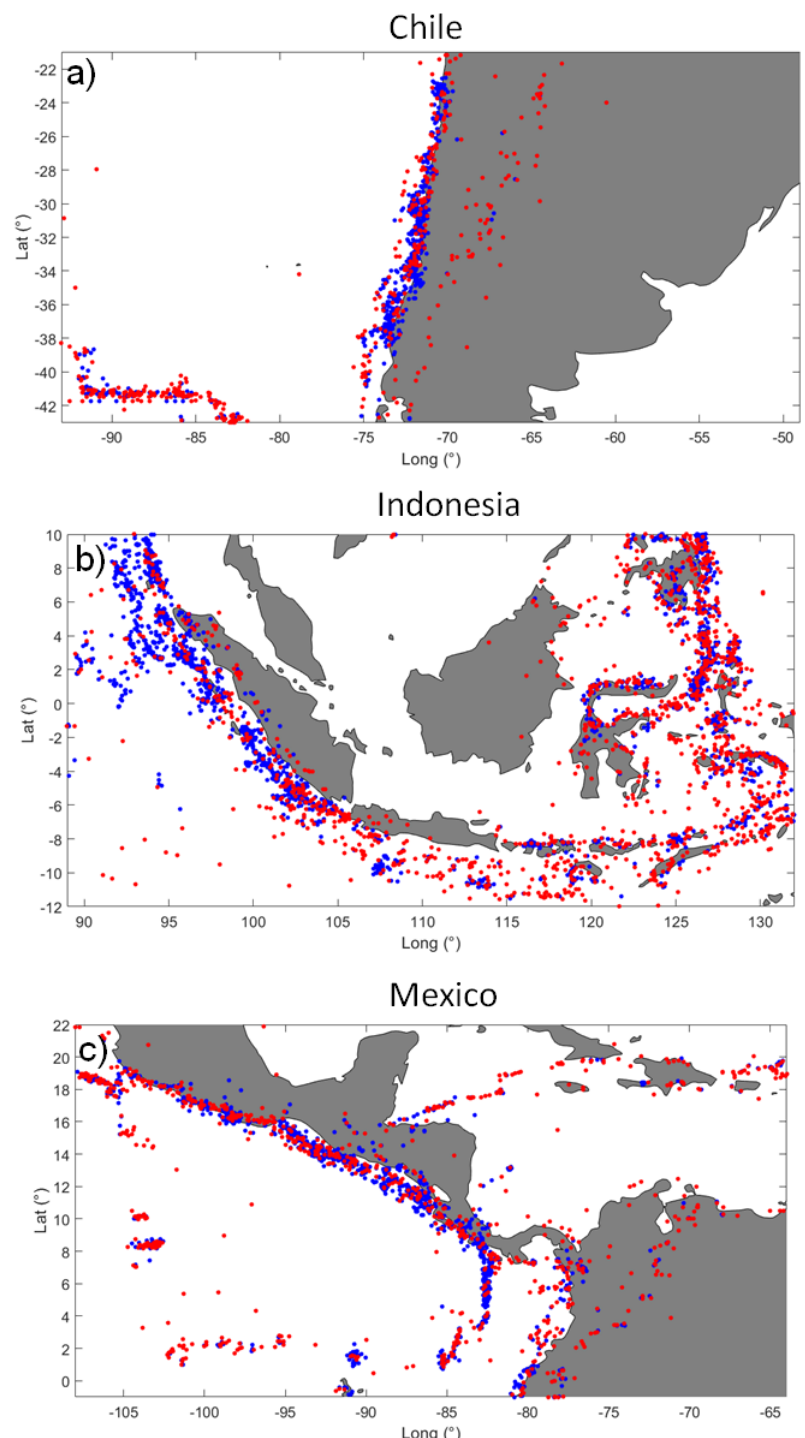
Figure 2. Location of earthquakes in the global centroid moment tensor (CMT) catalog with a depth ≤ 50 km recorded over the past almost 40 years between 1980 and 2019 [13,14]; ( a – c ) show the mainshocks (red dots) and foreshocks/aftershocks (blue dots) in some zones in the world: Indonesia, Mexico, and Chile.